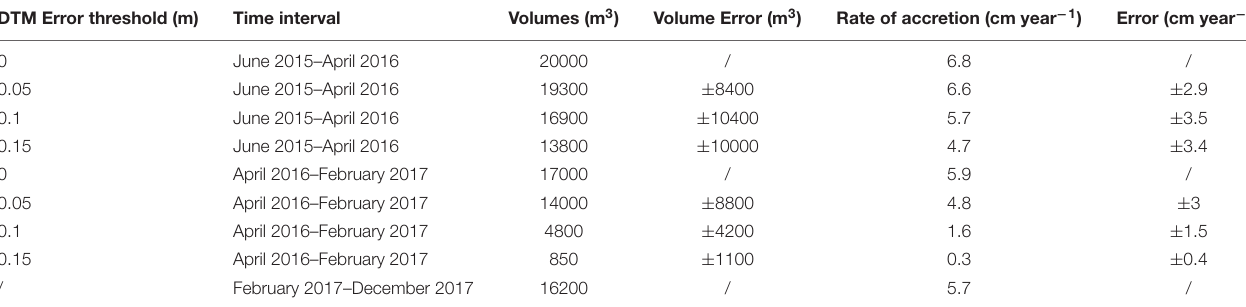
TABLE 1 | Volume changes and rates of accretion of the study area considering different thresholds for error in the DTM. DTM Error threshold (m) Time